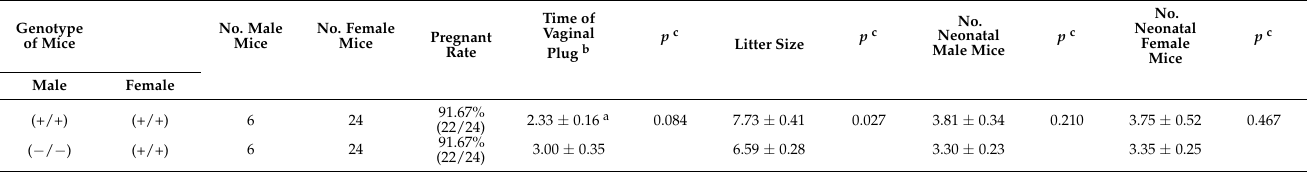
Table 1. Results of fertility disturbed by the LanCL1